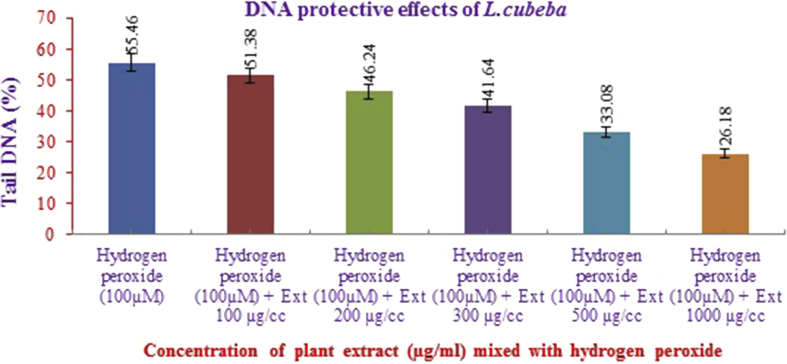
DNA Protective effects of L. cubeba.